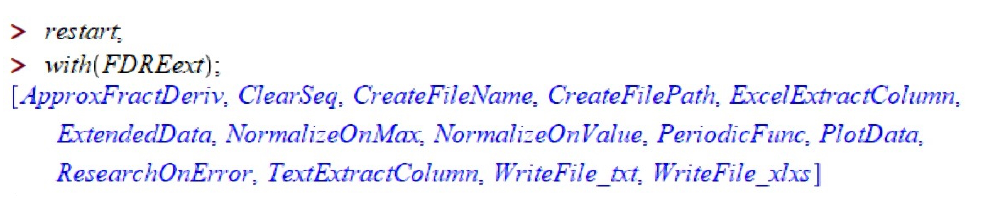
Figure 2. Library call